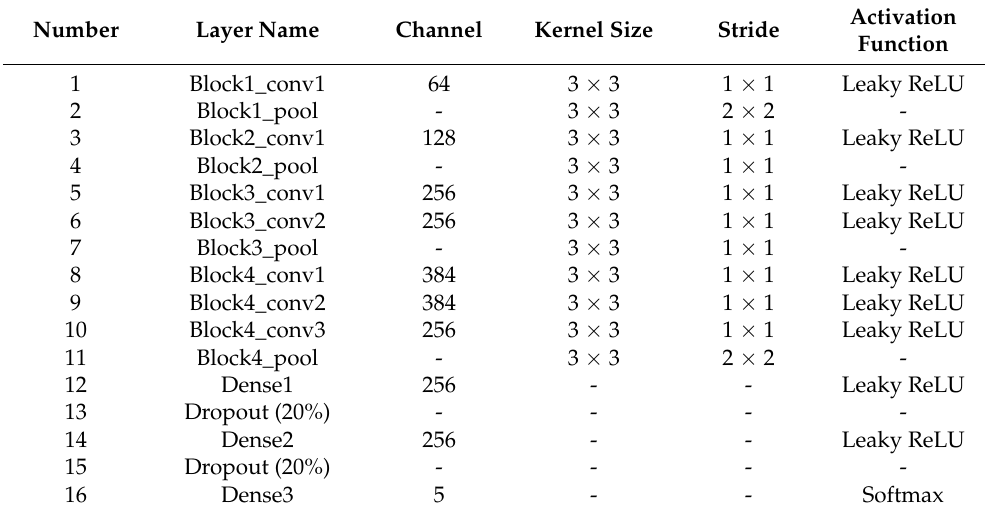
Table 3. Structure of proposed model.